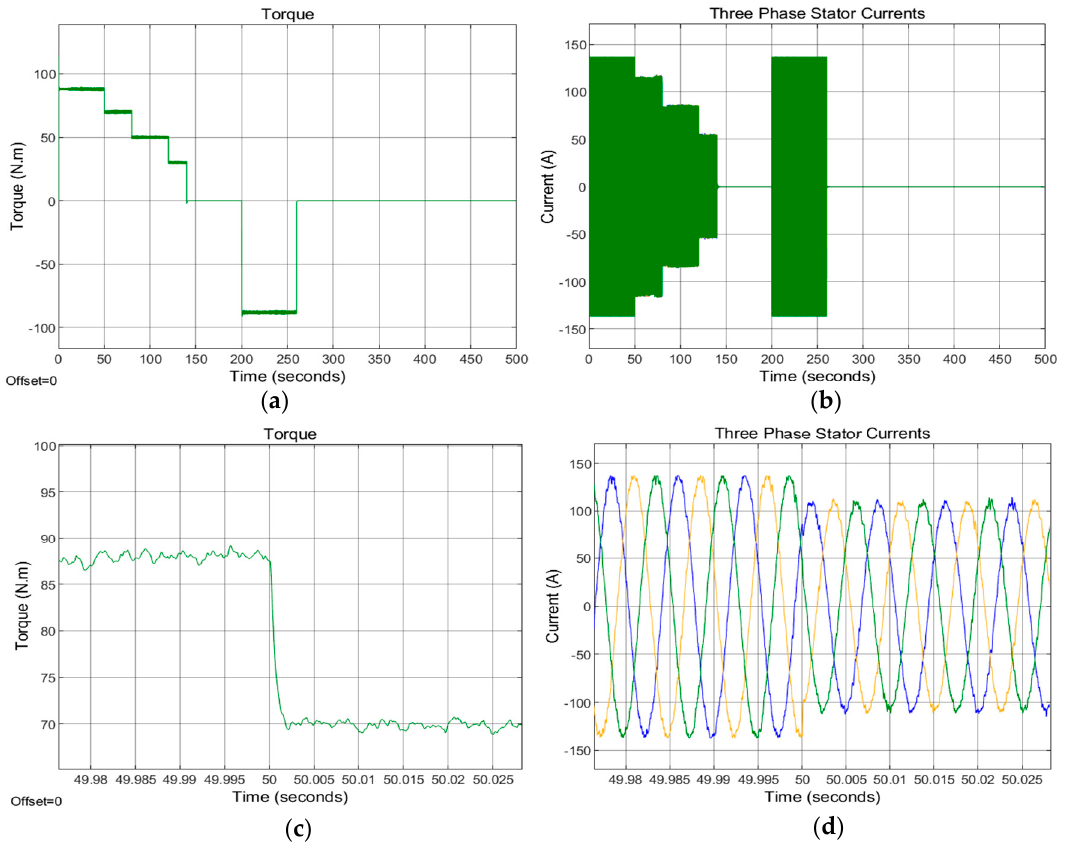
Figure 10. ( a ) Variable torque values; ( b ) Three phase currents at variable toque values; ( c ) Magnified view of change in torque command; ( d ) Magnified view of currents at t = 50